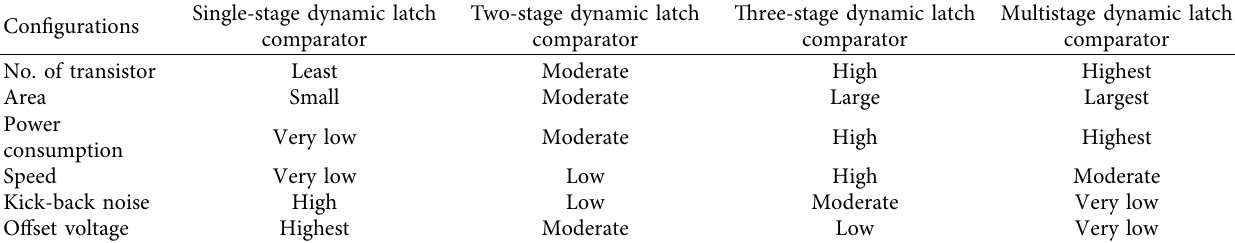
Table 2: Comparison between diferent confgurations of the